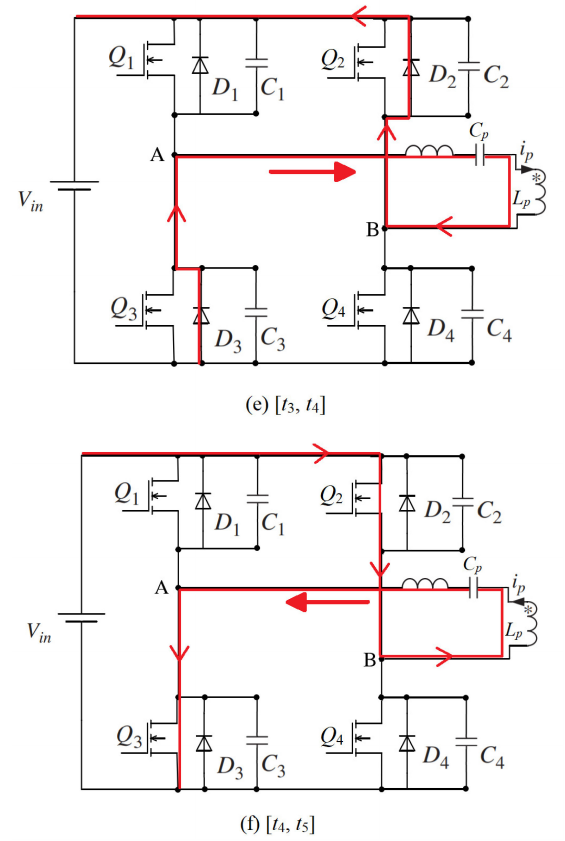
Figure 9. Equivalent circuits of different switching modes in soft-switching